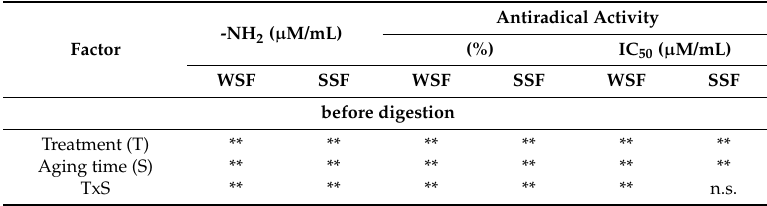
Table 1. Significance levels showed by the experimental factors and their interactions for the antiradical activity of dry-cured loins during long-term aging and in vitro gastrointestinal